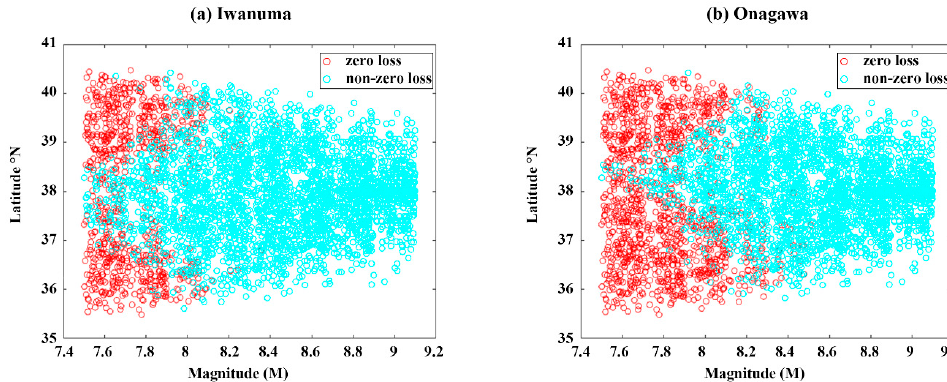
Figure 6. Magnitude–latitude plot for ( a ) Iwanuma and ( b ) Onagawa.